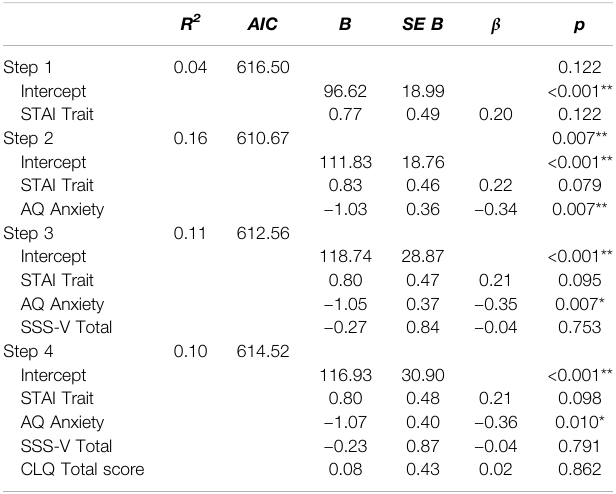
TABLE 5 | Summary of hierarchical regression analyses for psychometric questionnairescorespredictingtimespentonopenarmsofthevirtualmazein study 2.